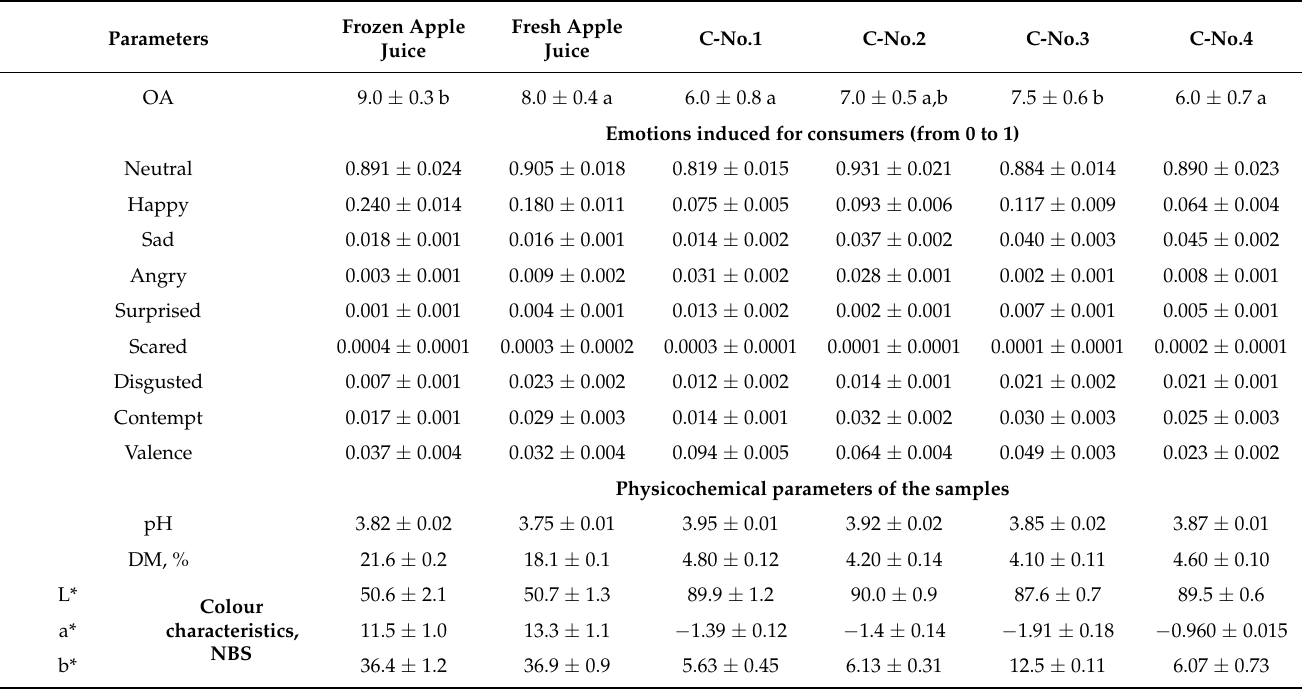
Table 2. Overall acceptability, emotions induced for consumers, and physicochemical parameters of apple juice and cider samples. Parameters